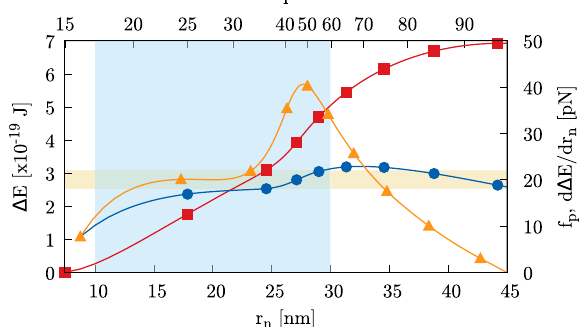
Fig. 5 Proteins and constriction forces. Red curve with squares: the energy needed to complete the fi ssion as a function of the current neck radius r n , Δ E = E ( r − E ( r r n ) 0 ) vs. n . The second abscissa axis on top of the frame provides the image number i along the MEP. Orange curve with triangles: estimated constriction force(secondordinateaxisontheright),d Δ E /d r n vs. r n .Bluecurve with dots: f p = Δ E ( r n )/( r n − r 0 ) vs. r n . The vertical light blue band represents the range in which dynamin polymerizes 74 . The horizontal light orange strip depicts the value of dynamin constriction force measured in experiments 34,74